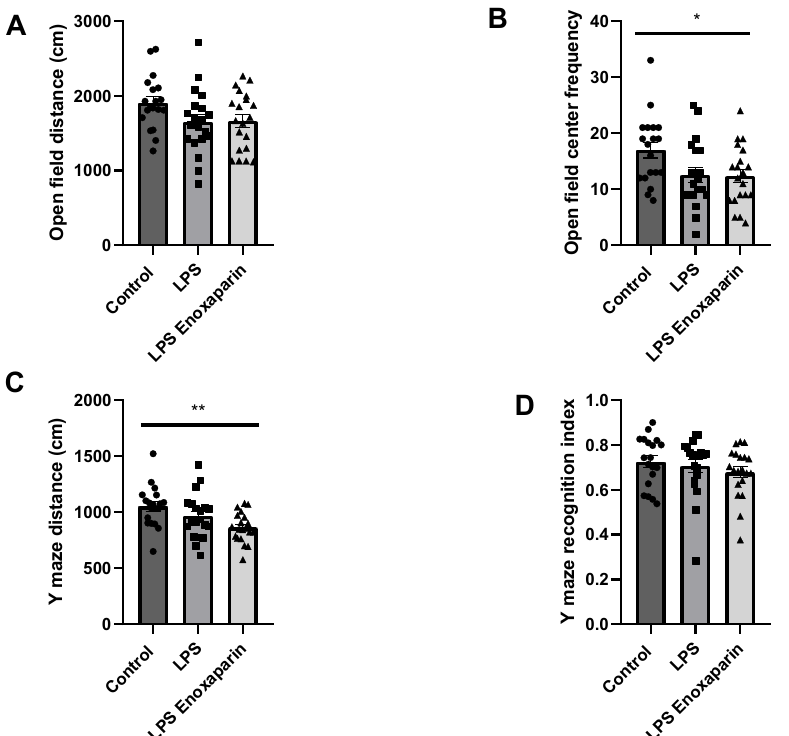
Figure 2. Cognitive deficits: ( A ) Both LPS and enoxaparin-treated LPS tended to travel shorter dis- tances compared to control and crossed the center fewer times compared to control animals ( B ). ( C ) LPS animals moved significantly shorter distances in the Y-maze compared to control. ( D ) Recog- nition index was similar in all groups (open field: control = 19, LPS = 20, LPS enoxaparin = 20. Y- maze: control = 19, LPS = 20, LPS enoxaparin = 20). * p < 0.05, ** p < 0.01. LPS—lipopolysaccharide. Circles—control group; squares—LPS group; triangles—enoxaparin-treated LPS group.